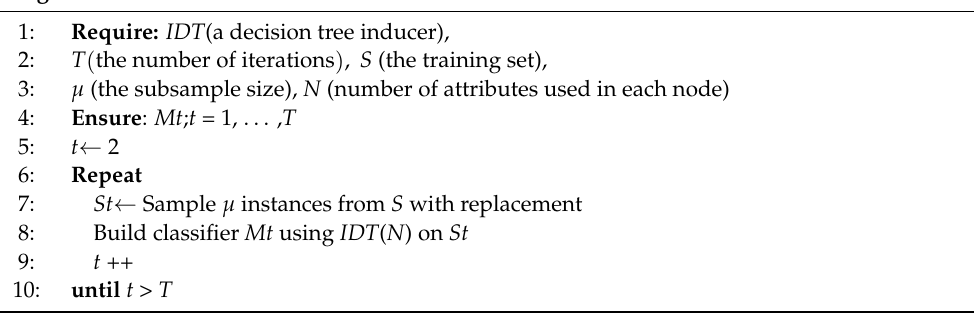
Algorithm A5 Random Forest Pseudo-Code